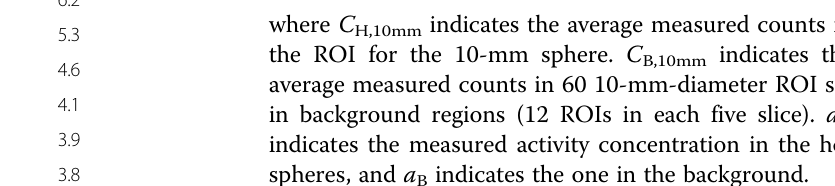
Table 5 Image quality results for a TBR of 4:1 Sphere diameter (mm) Contrast recovery Background variability